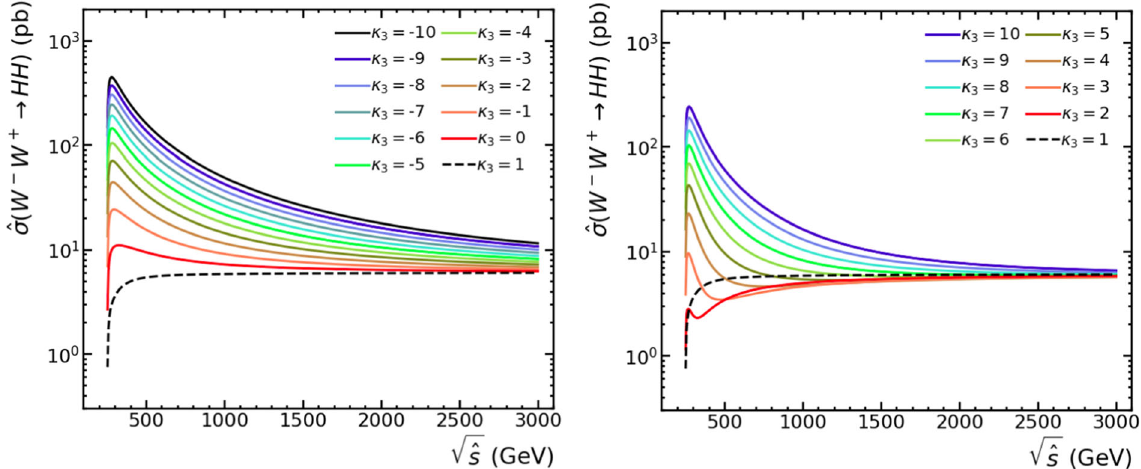
√ ˆ s for different values of the parameter κ κ 3 are shown in the left (right)